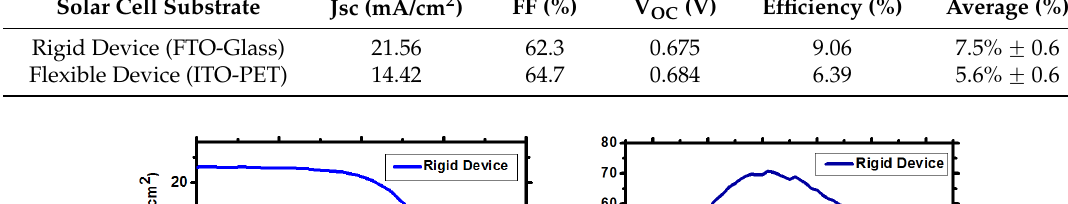
Table 1. Photovoltaic Parameters of ZnO/CH 3 NH 3 PbI 3 /Spiro-OMeTAD Solar Cells. Solar Cell Substrate